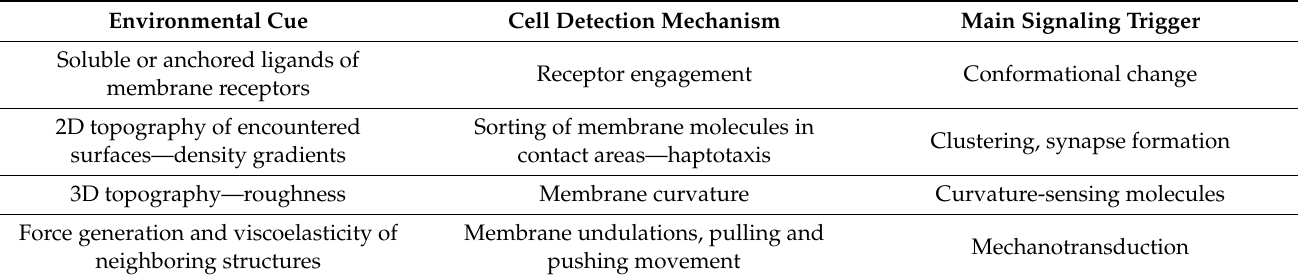
Table 1. How cells see the